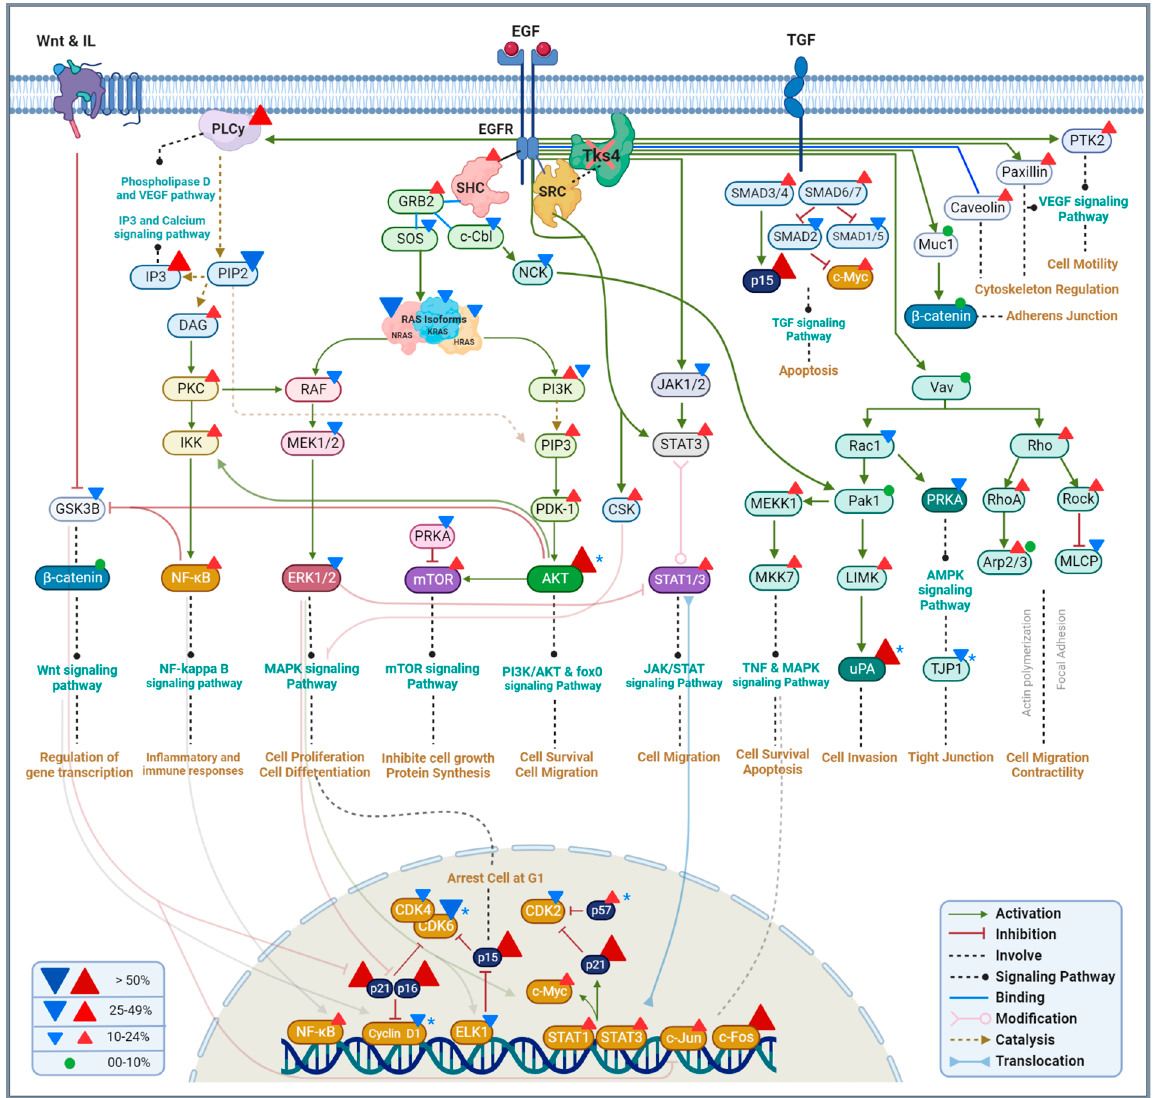
Figure 7. Schematic representation of the signaling pathways affected by the deletion of Tks4. Expression changes in the genes are represented by triangles (red for upregulation and blue for downregulation. When both are present, they refer to the expression changes in different subunits). Gene expression changes that were confirmed by RT ‐ qPCR are marked with blue asterisks. Dark colors represent central genes in a specific pathway.